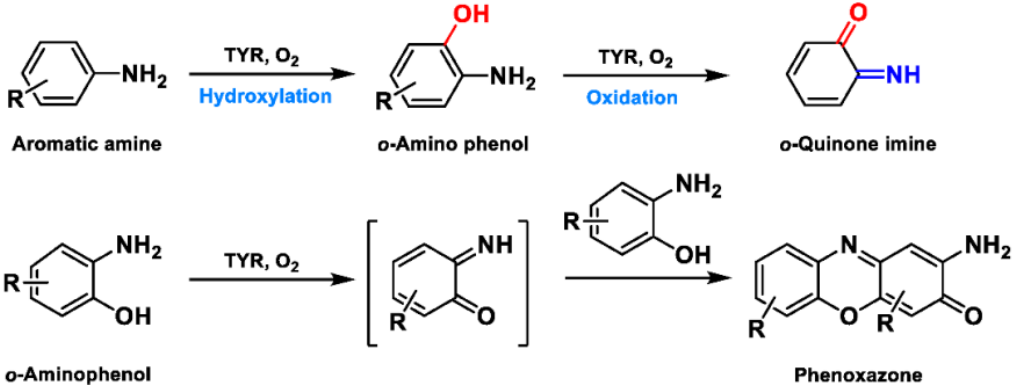
Figure 5. The catalytic reaction of TYR-mediated aromatic amine and o -aminophenol. Adapted with permission from ref. [43]. 1987, American Chemical According to the chemical stability of the corresponding o -benzoquinone, phenolic substrates (Table 1) can be roughly divided into the following three categories [42,44]. (1) The first sort of substrates catalyzed by TYR could yield stable o -quinones. For example, 4- tert -butylcatechol (TBC) is detectable for the diphenolase activity, whose o -quinone is exceedingly stable. (2) The second substrates produce a highly unstable o -quinone but evolve into a stable product via a first-order reaction. Targeted at diphenolase activity, the common determination is based on the formation of dopachrome using L-DOPA as a substrate. Moreover, there is 3,4-dihydroxymandelic acid (DOMA) [45], dopamine (DA) [46], and isoproterenol (ISO) [47]. (3) The third kind of substrates are oxidized to an un- stable o -quinone that is vulnerable to potent nucleophiles (N) and yields chromatic ad- ducts (NQ) with a clear stoichiometry. Commonly used nucleophiles include L-proline (Pro) [48], L-cysteine (Cys) [49], and especially 3-methyl-2-benzothiazolinone hydrazone (MBTH)